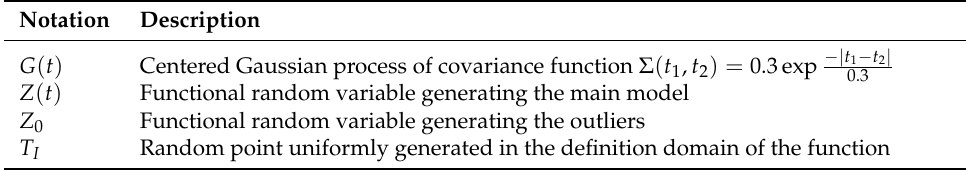
Table 1. Description of the common parameters of the